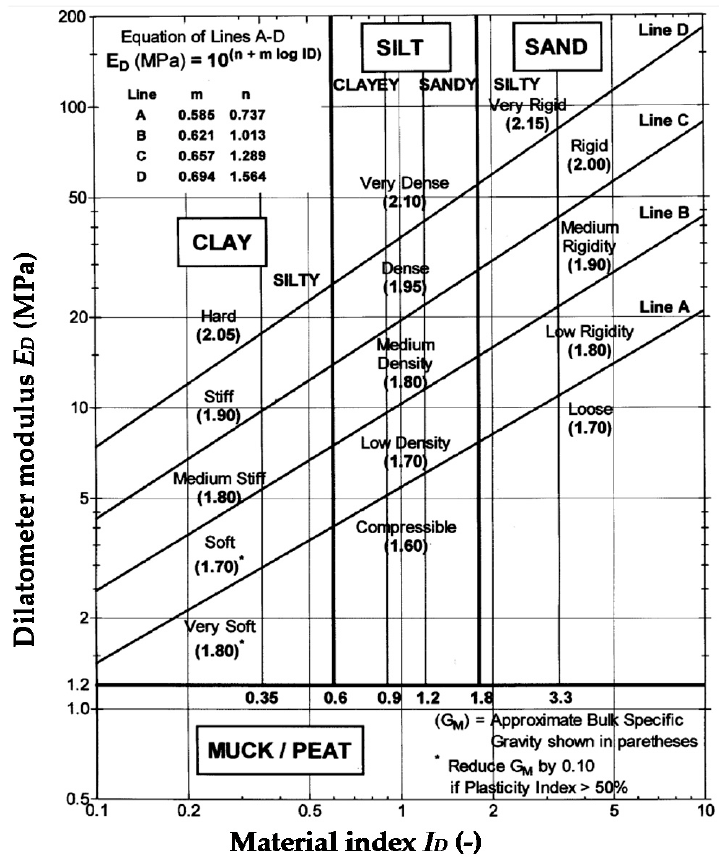
based on the adjusted value of the material index I D(kor) and the dilatometer modulus E D , is shown in Figure 4. The characterization of soil on the corrected material index I D(kor) ≤ 0.6 (Table 1) is based on undrained shear strength τ fu , using the division proposed by Leroueil and co-workers [25] (Table 2). Figure 2. Chart for estimating soil type and unit weight for soil (normalized to γ w ) [1,2].